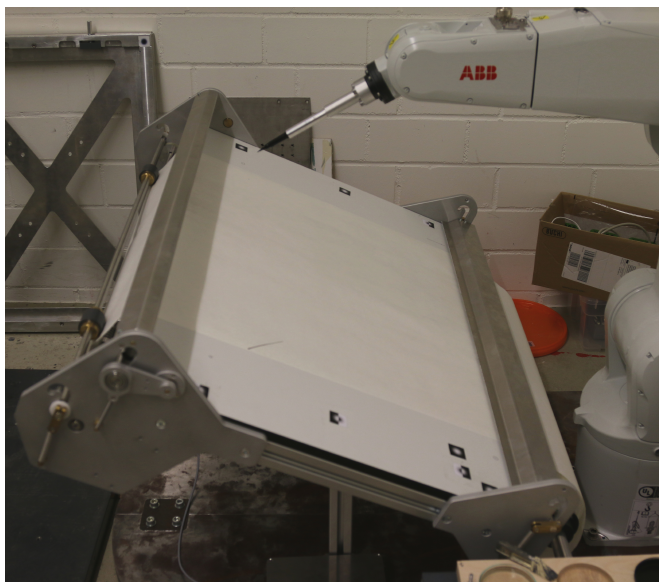
Figure 5. The paper feed